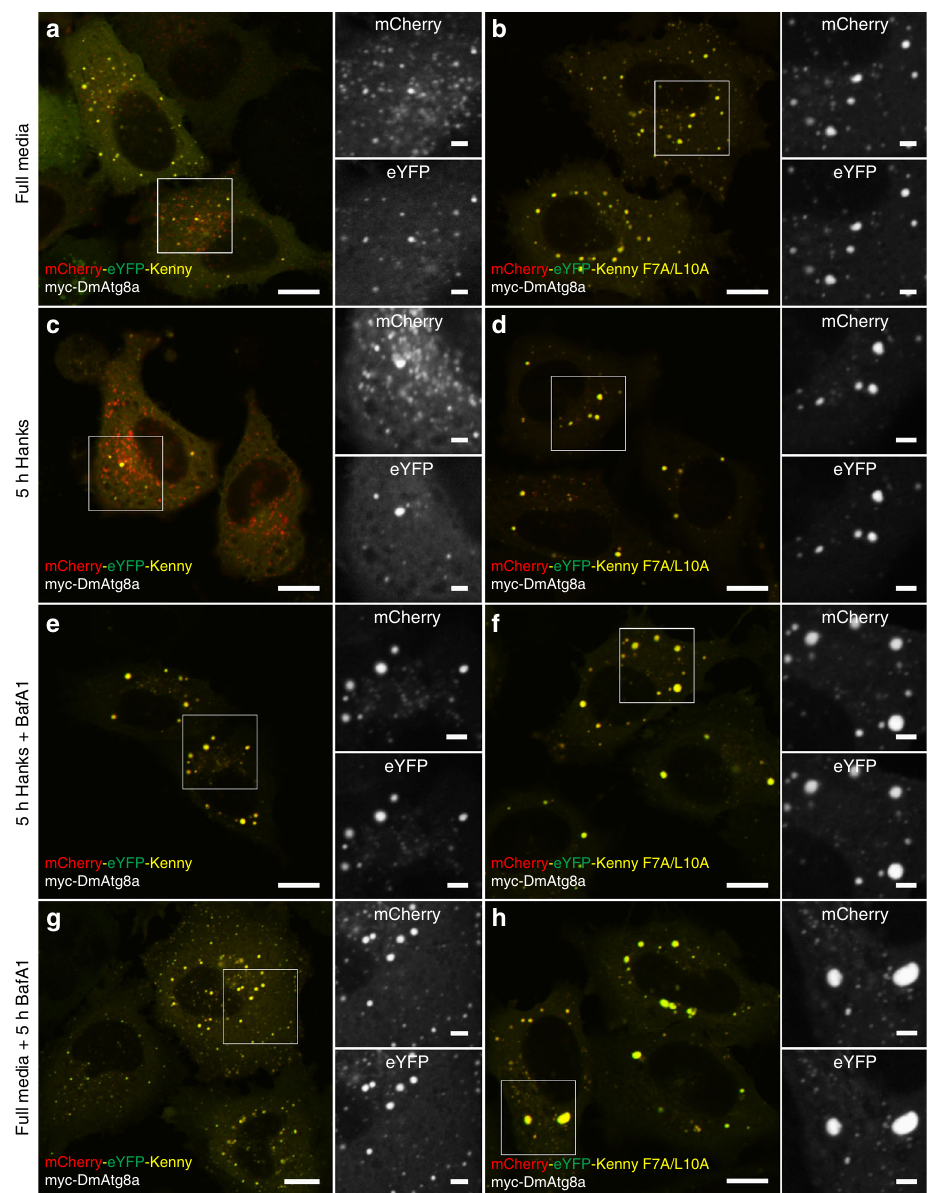
Fig. 5 Autophagic degradation of Kenny in HeLa cells depends on a functional LIR motif and its interaction with co-expressed Atg8a. Confocal images of HeLa cells transiently expressing tandem tagged, mCherry-eYFP-Kenny WT or F7A/L10A (red and green) and Myc-Atg8a. a , b Cells cultured in full media. c , d Cell starved for 5 h in Hanks media to activate autophagy. e , h To inhibit lysosomal degradation, the cells in full media e , f or Hanks media g , h were treated with Ba fi lomycin A1 (BafA1). Insets on the right of merged channels show the separate red and green channels. Scale bars are 10 and 2 µ m